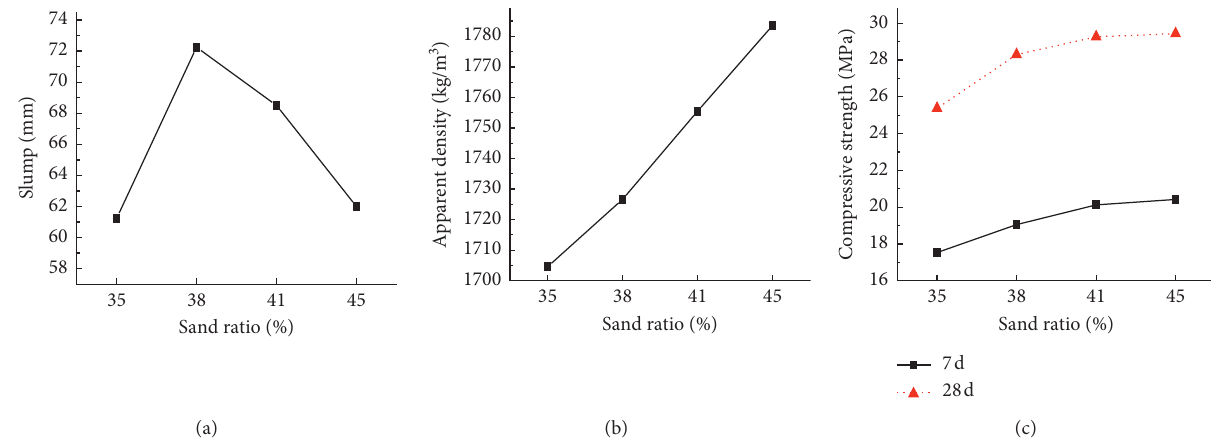
Figure 2: Curves of relationship between sand ratio and performance of desert sand ceramsite concrete. (a) Trend curve of slump. (b) Trend curve of 28days’ natural apparent density. (c) Trend curve of 7 and 28days’ tube crushing strength.